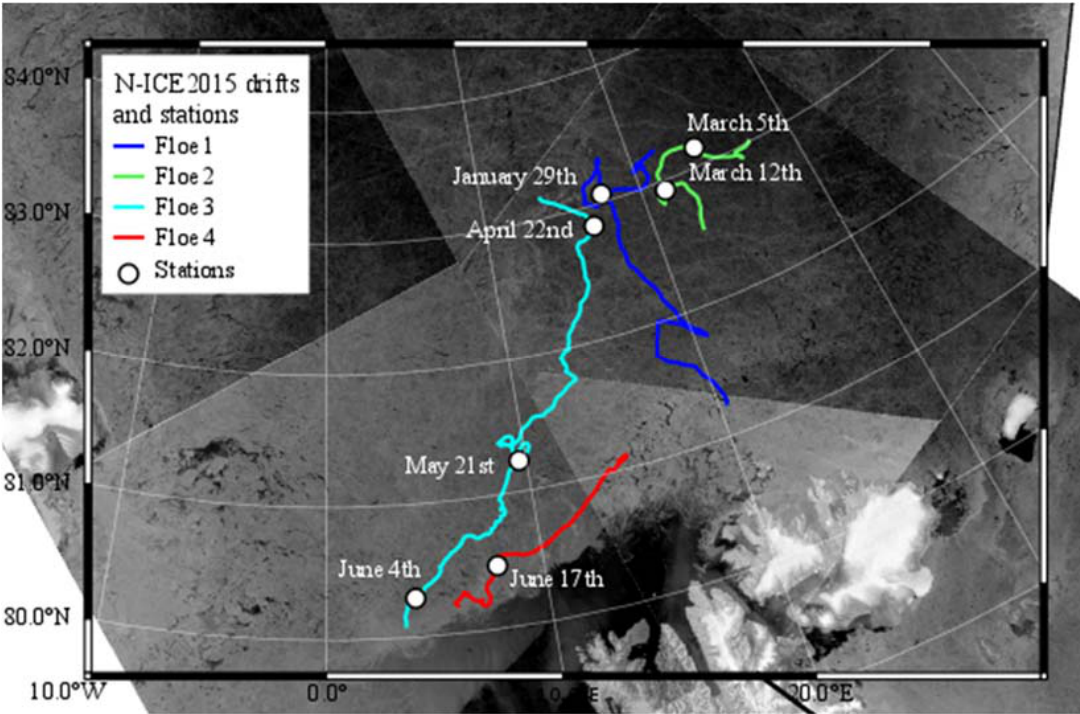
Figure 1. Map of the sampling area with the four different ice Floe drift tracks color ‐ coded and the ice core samples used in/available for this study indicated by date. Image source: RADARSAT ‐ 2 image provided by NSC/KSAT under the Norwegian ‐ Canadian RADARSAT agreement. RADARSAT ‐ 2 Data and Products © MacDonald, Dettwiler and Associates Ltd. (2013) All Rights Reserved. RADARSAT is an official mark of the Canadian Space Agency. Map created by the Norwegian Polar Institute.